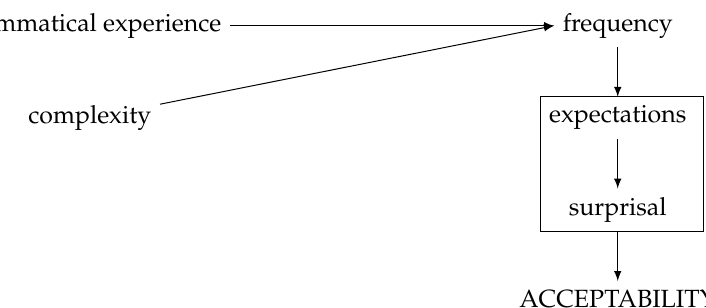
Figure 2. The logic of acceptability judgments for grammatical conditions, version